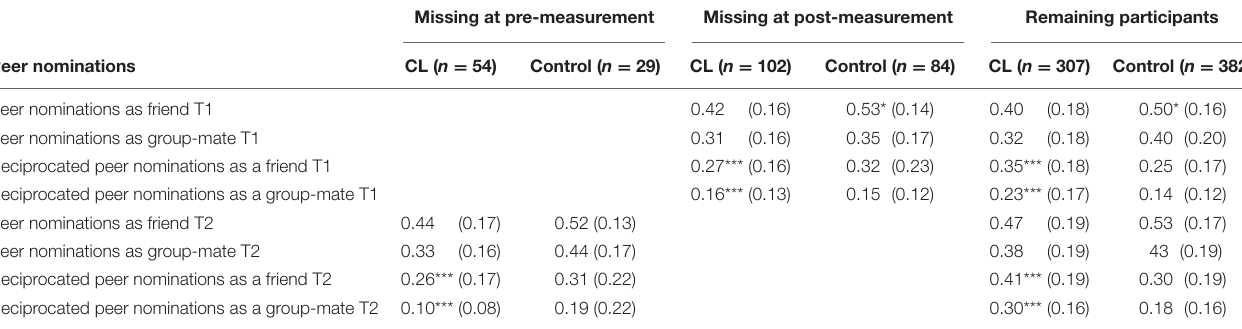
TABLE A2 | Students’ peer nominations, reported separately for those with missing values at pre-measurement, post-measurement, and remaining participants. Missing at pre-measurement Missing at post-measurement Remaining